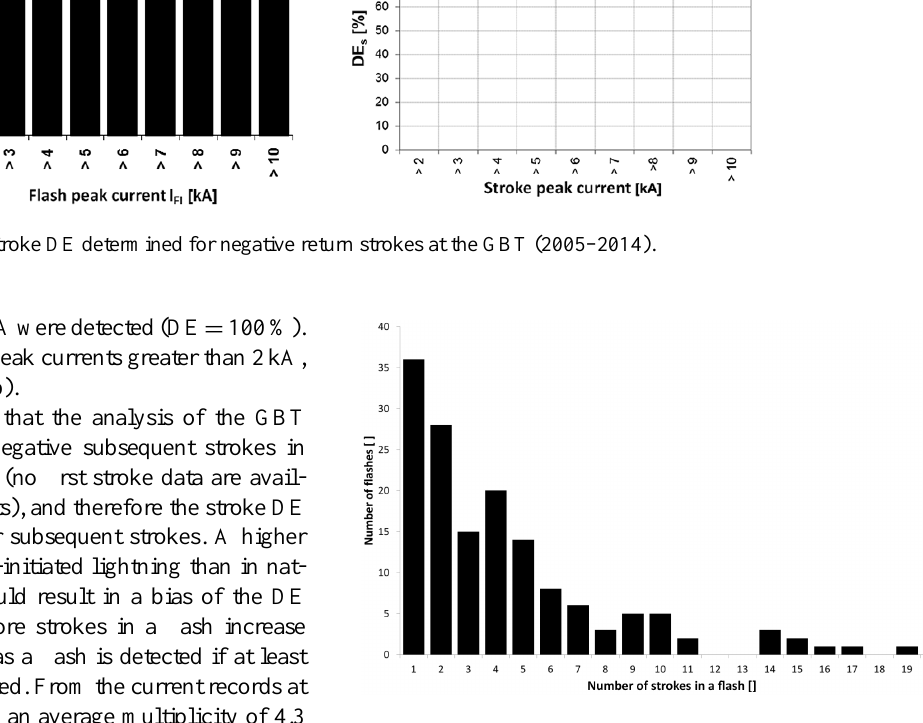
Figure 7. Histogram of number of return strokes in negative flashes to the GBT (2005–2014), sample size N =